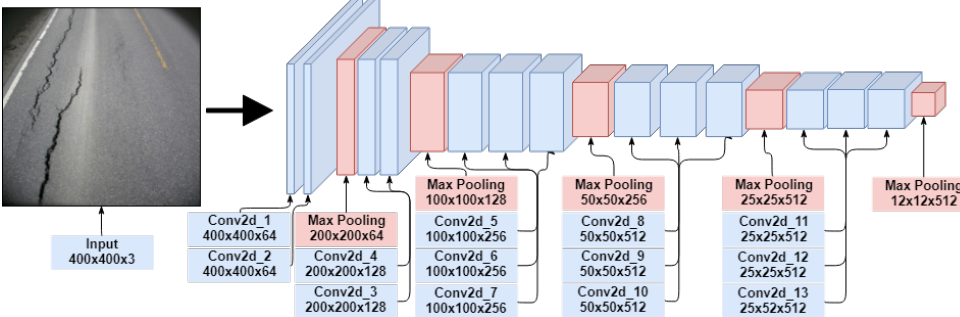
Figure 3. An illustration of the convolution and max-pooling layers of the VGG-16 network used in the